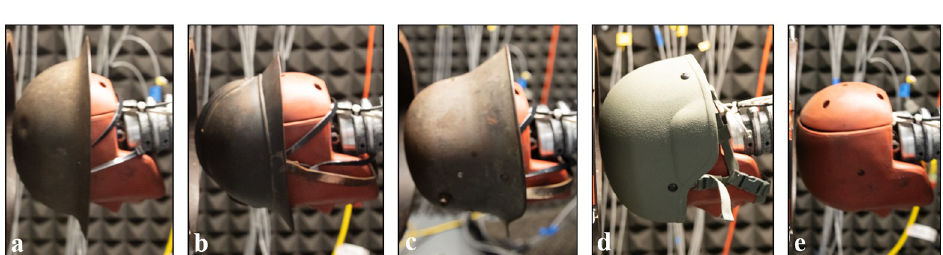
Fig 2. Helmets on Hybrid III head in test setup. (a) Brodie helmet, (b) Adrian helmet, (c) Stahlhelm, (d) Advanced Combat Helmet, (e) No helmet.